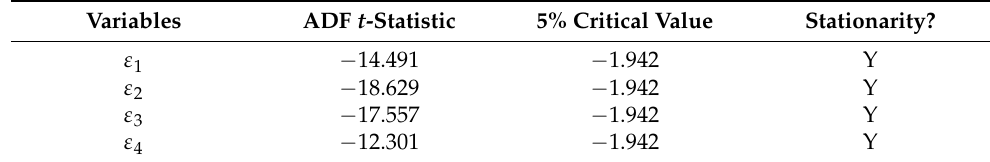
Table 3. ADF test results for the training residuals.